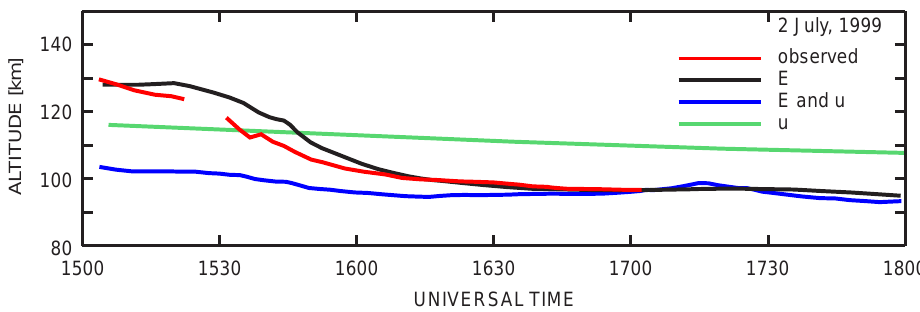
Fig. 2. Red line: Altitude of the peak of the observed layer in Fig. 1. Black line: Altitude of the calculated layer assuming the presence of electric field only. Green line: The same assuming the presence of neutral wind only. Blue line: The same assuming the presence of both electric field and neutral